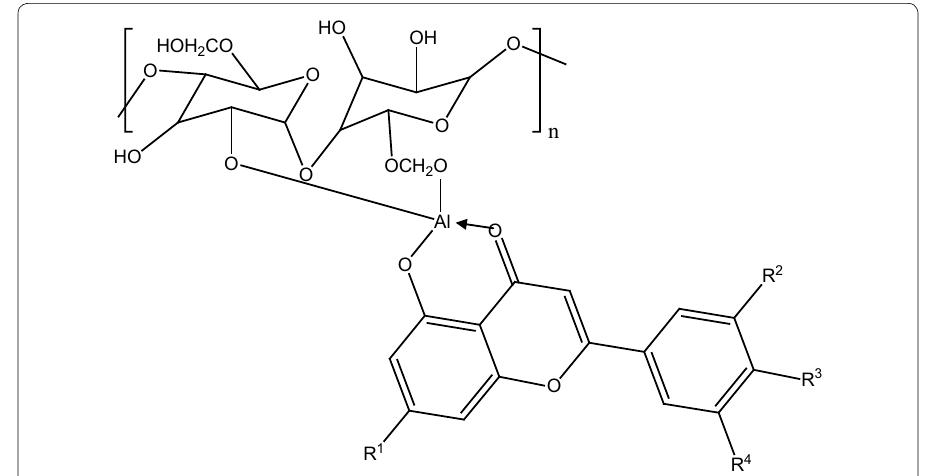
Fig. 4 Alum mordanted B. ferruginea dyed cellulosic